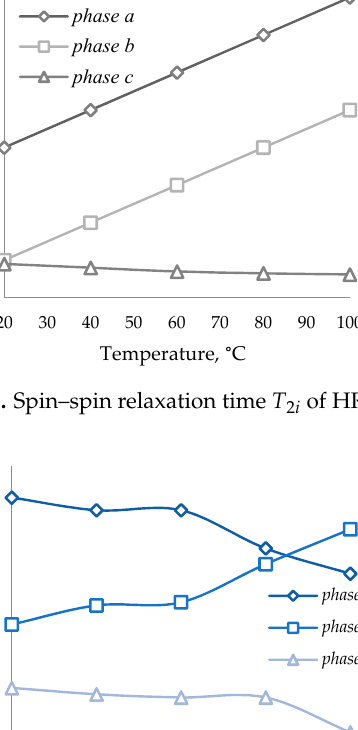
Figure 3. Spin–spin relaxation time T 2 i of bitumen vs. temperature.